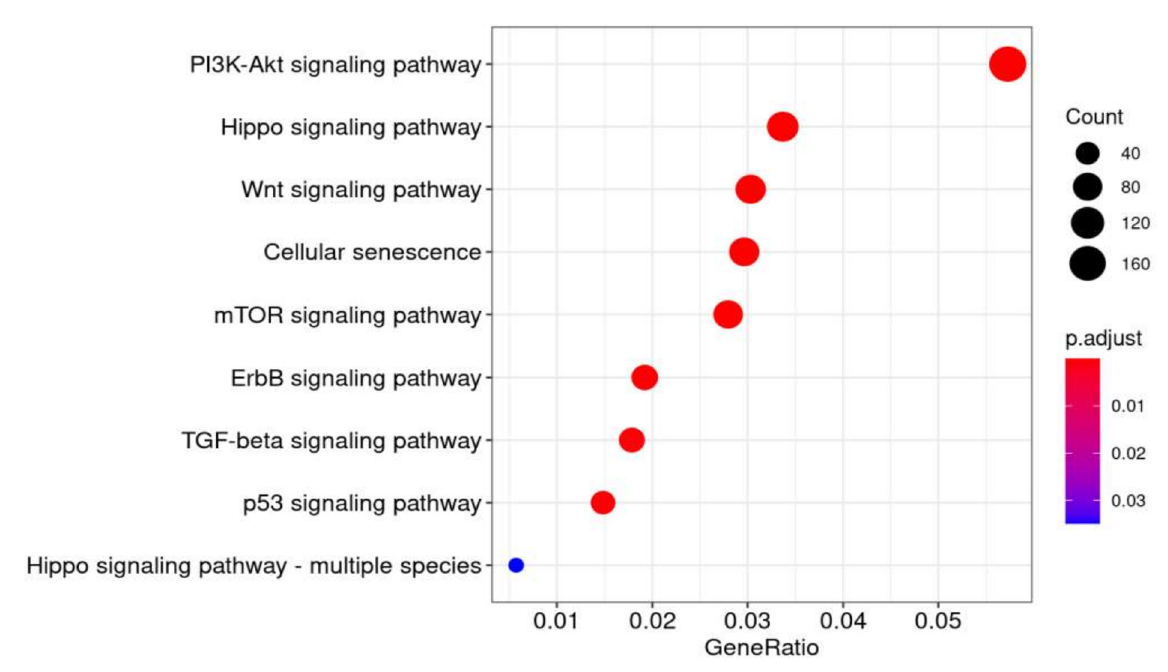
Figure 4. Functional analysis of common predicted gene targets for miR-320c, miR-200c-3p, and miR-449c-5p. DIANA-miRPath v3.0 was used for KEGG pathway enrichment based on predicted miRNA targets provided by the DIANA-microT-CDS algorithm. Gene ratios is the ratio of input genes that are annotated in a term. P-adjust is adjusted p -value. The method used for this correction was Benjamini–Hochberg